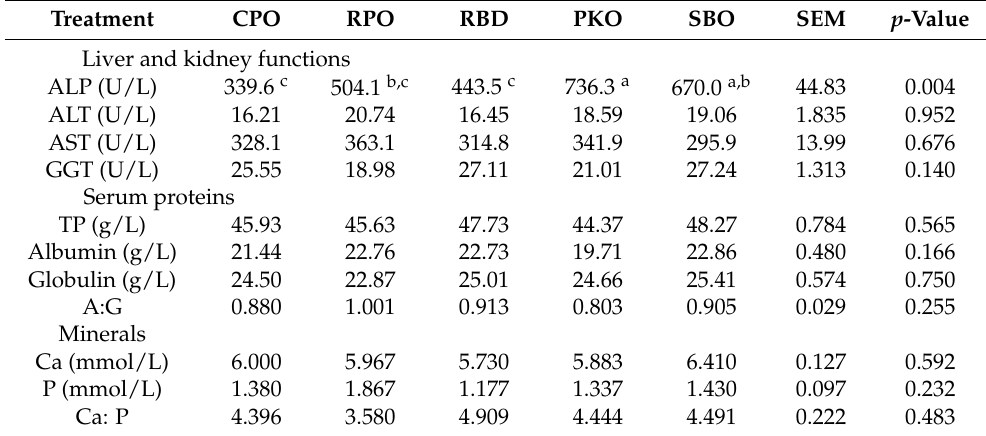
Table 5. Serum biochemical profiles in laying hens fed different oils.